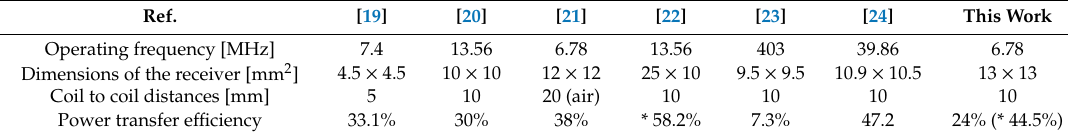
Table 5. Comparison of the proposed design with related works.